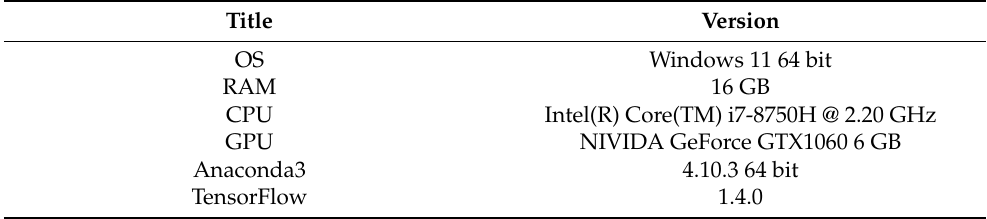
Table 2. The environment of the